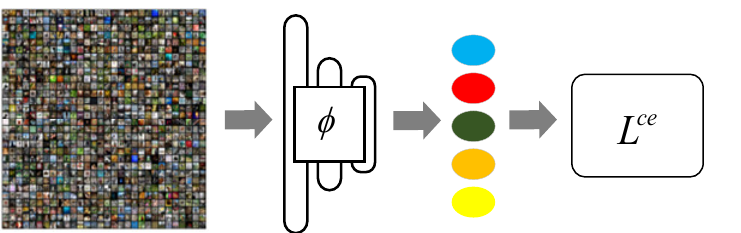
Figure 2. Schematic diagram of the training embedding model. Training the embedding model φ using the merged meta-training set. L ce represents the cross-entropy loss function.